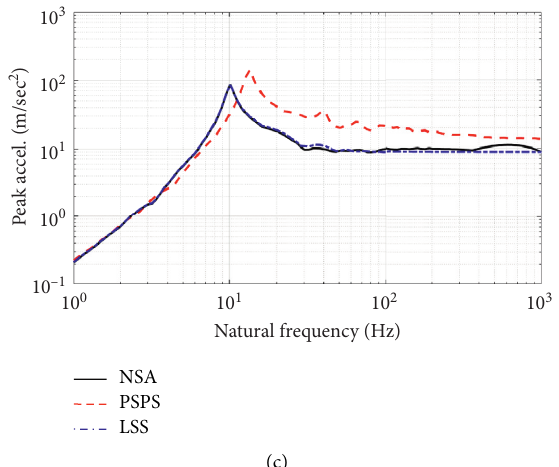
Figure 13: The shock response of the systems ( μ � 6 . 7 × 10 − 4 , m � 1kg, n � 1, A � 5 N , F � 50 N , w � 200 π /s). (a) Ω � 100. (b) Ω � 30. (c) Ω � 20. (d) (e) (f)